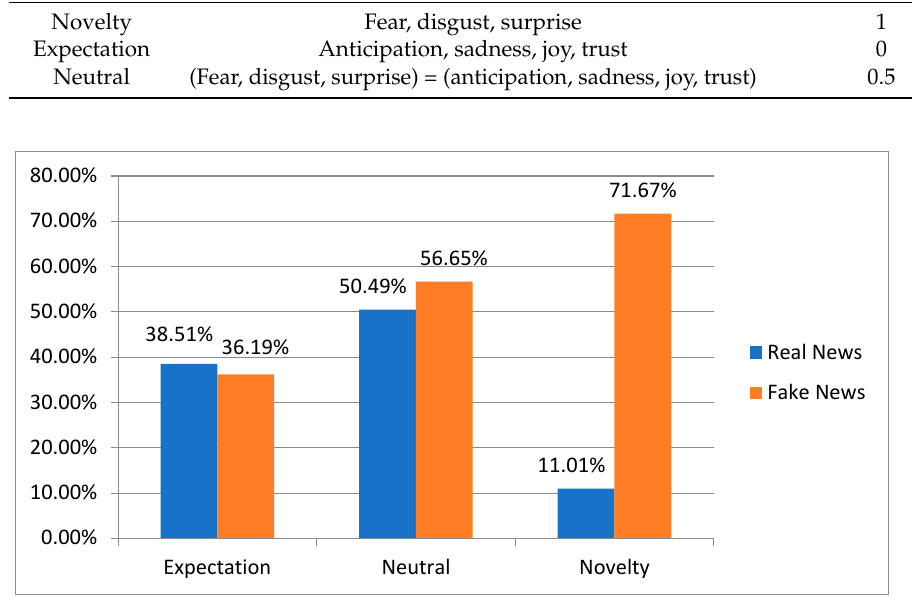
Figure 7. The groups of emotion analysis of comments in the Fakeddit dataset.